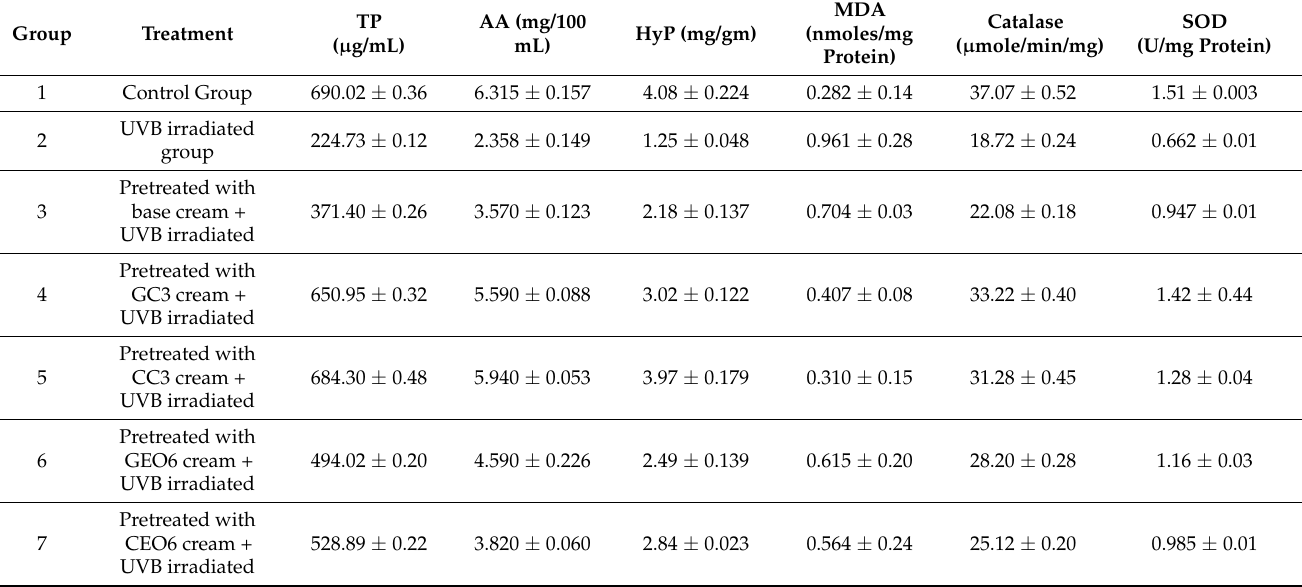
Table 3. Effect of UVB radiation and cream formulations on Total Protein (TP), Ascorbic Acid (AA), Hydroxyproline (HyP), Malondialdehyde, Catalase and SOD levels in rat